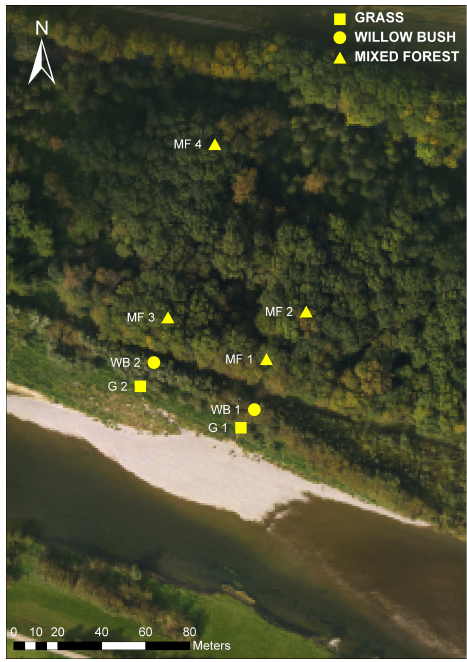
Fig. 1. Aerial view of the Thur River test site near Niederneunforn (NE Switzerland) showing the different plots in the three functional process